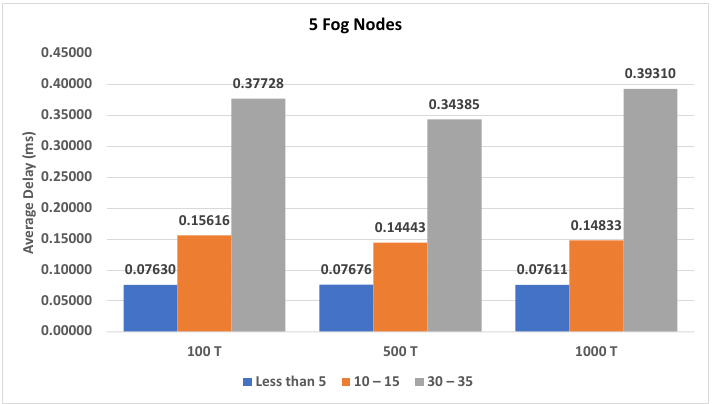
Figure 8. The impact of the different sets of affected transactions on five fog nodes